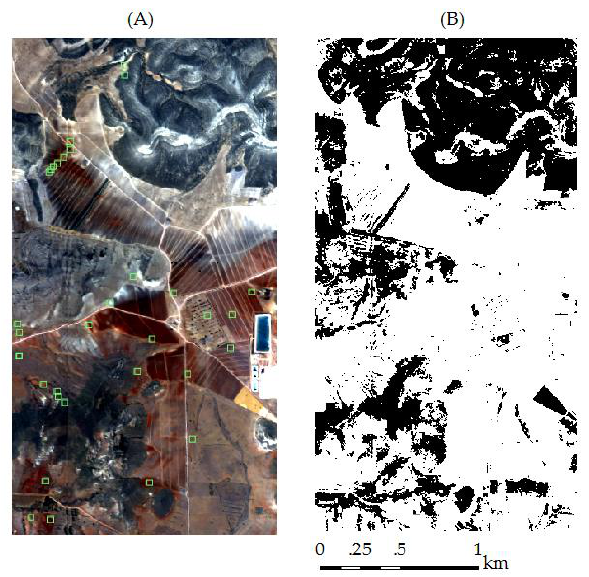
Table 1. Statistics of soil clay content for the calibration and validation dataset.